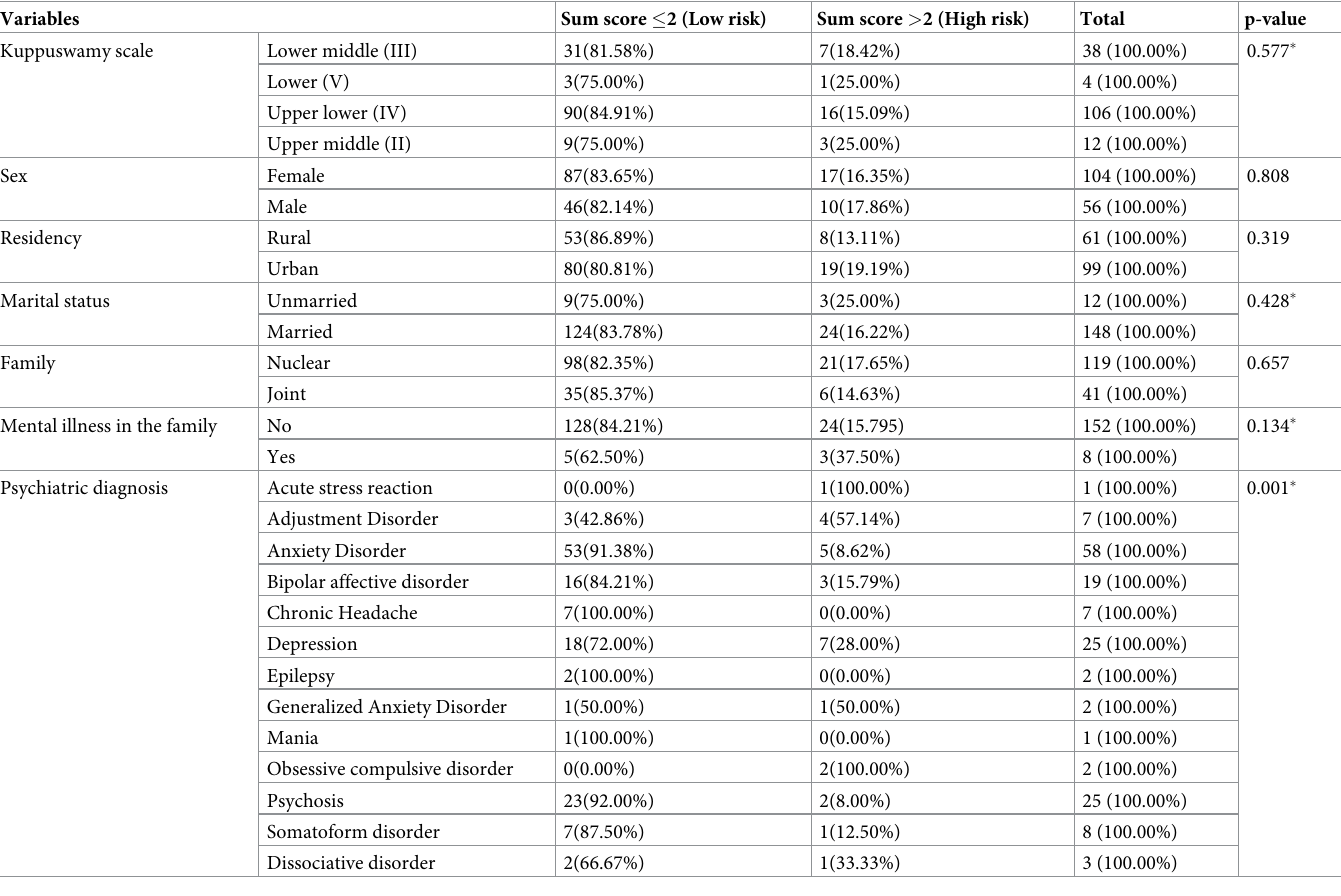
Table 3. Cross-tabulation of independent variables across dependent variables using chi-square